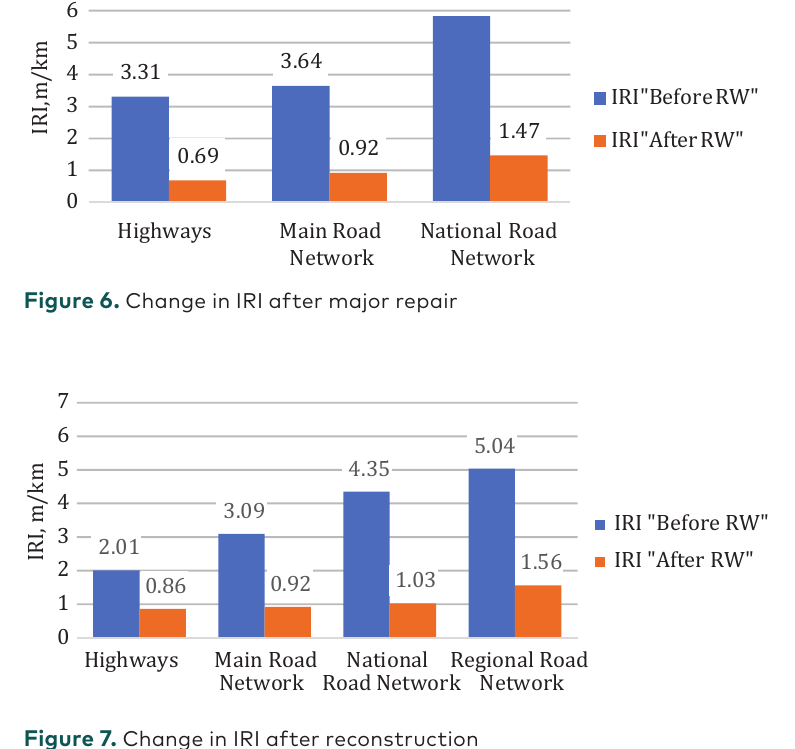
Figure 7. Change in IRI after